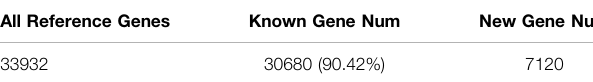
TABLE 3 | Statistics of gene expression results.